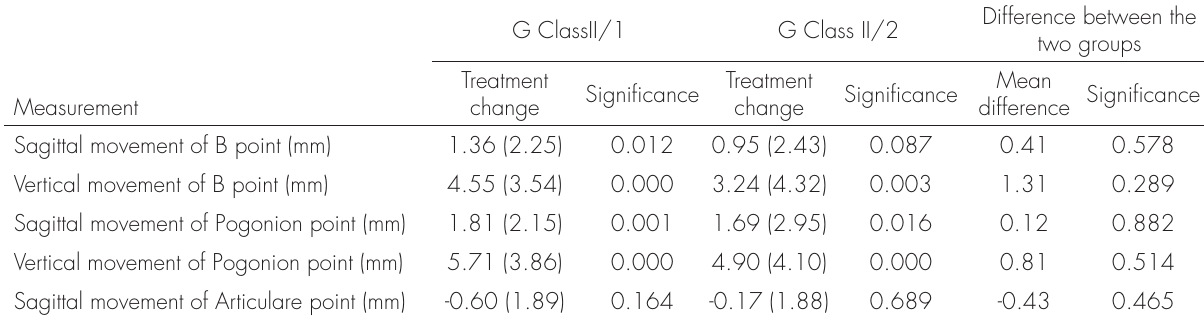
Table VIII. The linear measurements that represent average changes in the mandibular position after treatment for both growing (G) groups with their statistical